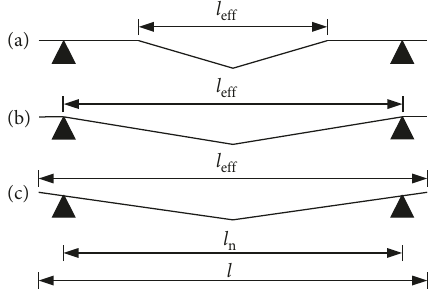
Figure 5: Determination of the effective response